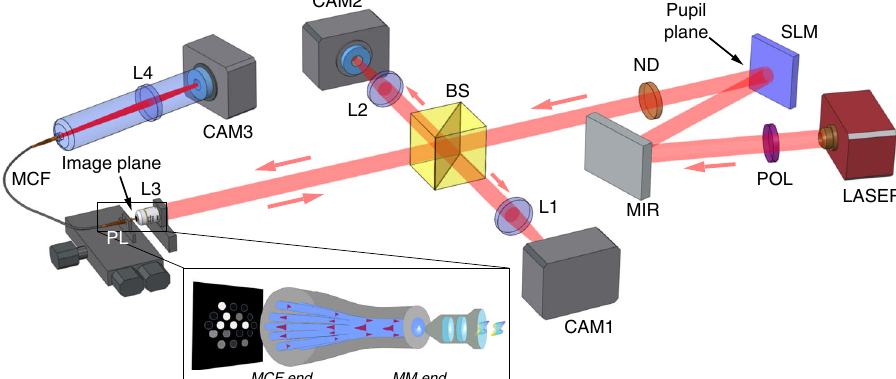
Fig. 3 Diagram of the laboratory setup used for testing the photonic lantern wavefront sensor. A collimated 685 nm laser (LASER) is passed through a linear polariser (POL) and via a fold mirror (MIR) onto a spatial light modulator (SLM), with a neutral density fi lter (ND) used to attenuate the beam. A wavefront constructed from a chosen set of Zernike terms is created by the SLM and focused to an image and injected by a microscope objective (L3) into the multimode end of the photonic lantern (PL). The intensity of the 19 outputs is then transmitted via multicore fi bre (MCF) measured by a camera (CAM3) via lens L2. The raw PSF is also imaged via beamsplitter BS and lens L1 onto camera CAM1. The back-re fl ection off the fi bre tip is imaged via the same beamsplitter and separate imaging system (L2, CAM2) to aid with alignment. Inset: illustration of the principle of the photonic lantern WFS. The incident aberrated wavefront is focused to an image at the focal plane, where the multimode end of the photonic lantern is placed. The complex wavefront determines the combination of modes excited within the multimode region, which are then translated via an adiabatic taper transition into an array of single-mode outputs, the intensities of which encode the complex wavefront information.